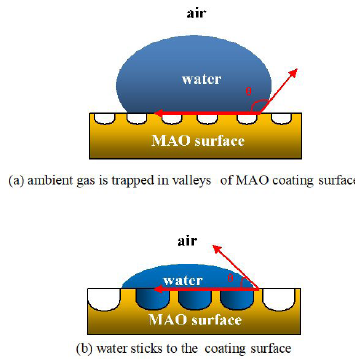
Figure 9. Contact angle of the samples untreated and subjected to MAO treatment applied various voltages.